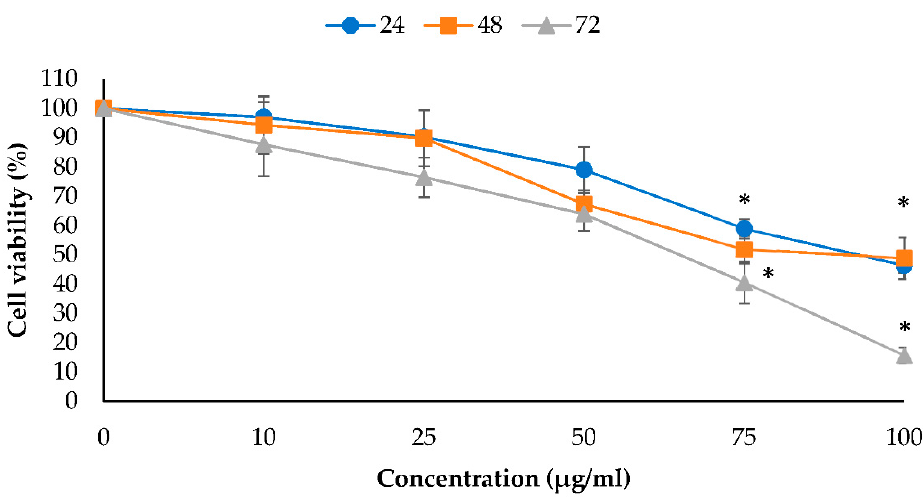
Figure 1. Anti-proliferative effect of EO-L in PANC-1 cells. PANC-1 cells were treated with 10–100 µg/mL of EO-L for 24, 48 and 72 h. The anti-proliferative effect was measured by MTT assay. The data were shown as the mean values ± S.D. for three independent experiments, and the statistical analysis was determined using a Student’s t -test, with the * symbol showing a significant difference ( p < 0.05) in comparison to control untreated cells.